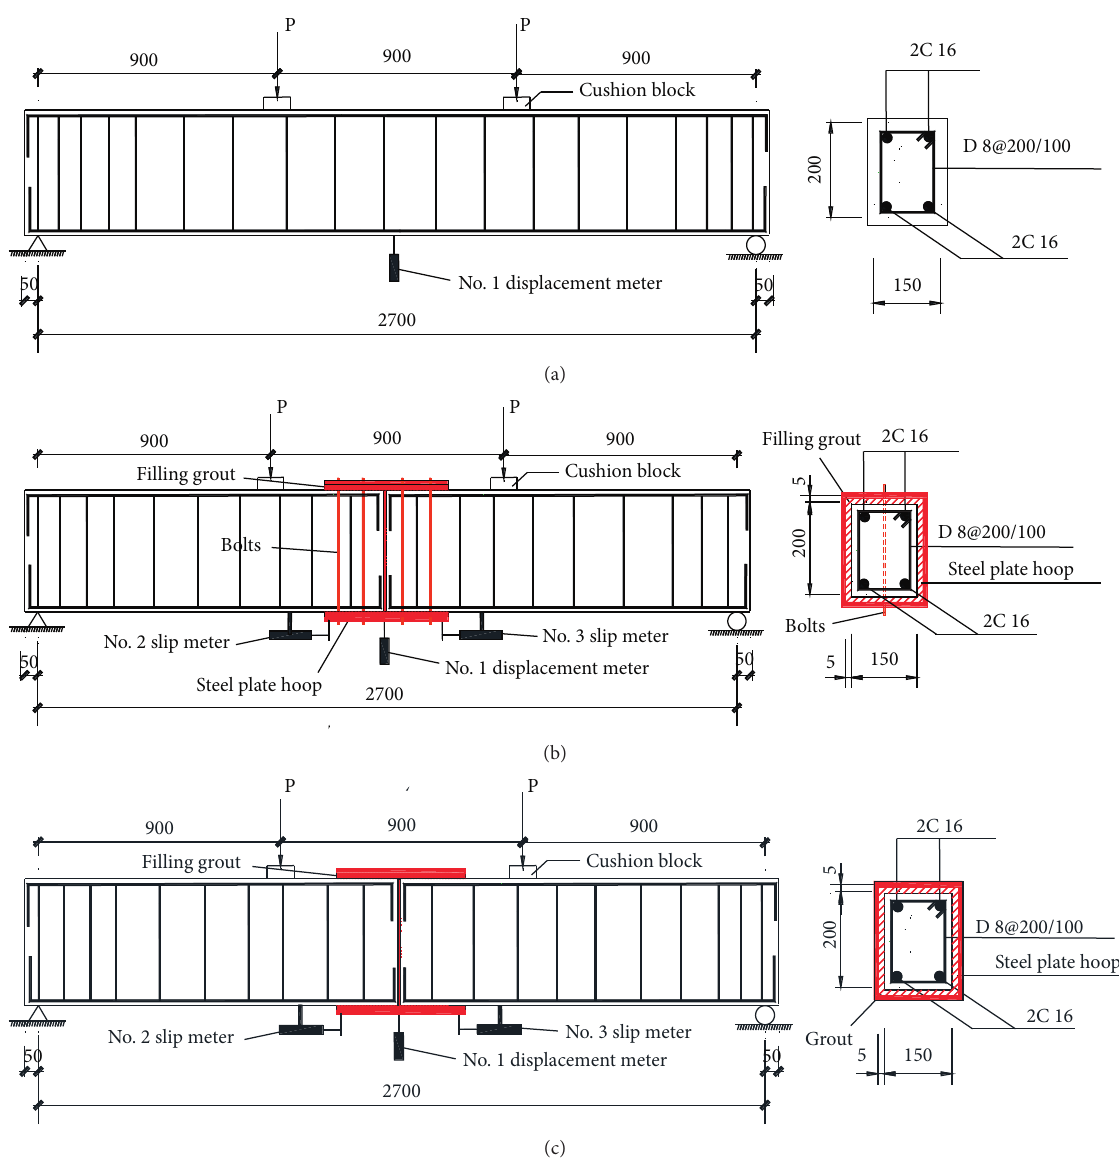
Figure 2: Specific size and structure of specimen. (a) Size and reinforcement of RCB-00, (b) size and reinforcement of PRCB-01 and PRCB- 02, and (c) size and reinforcement of